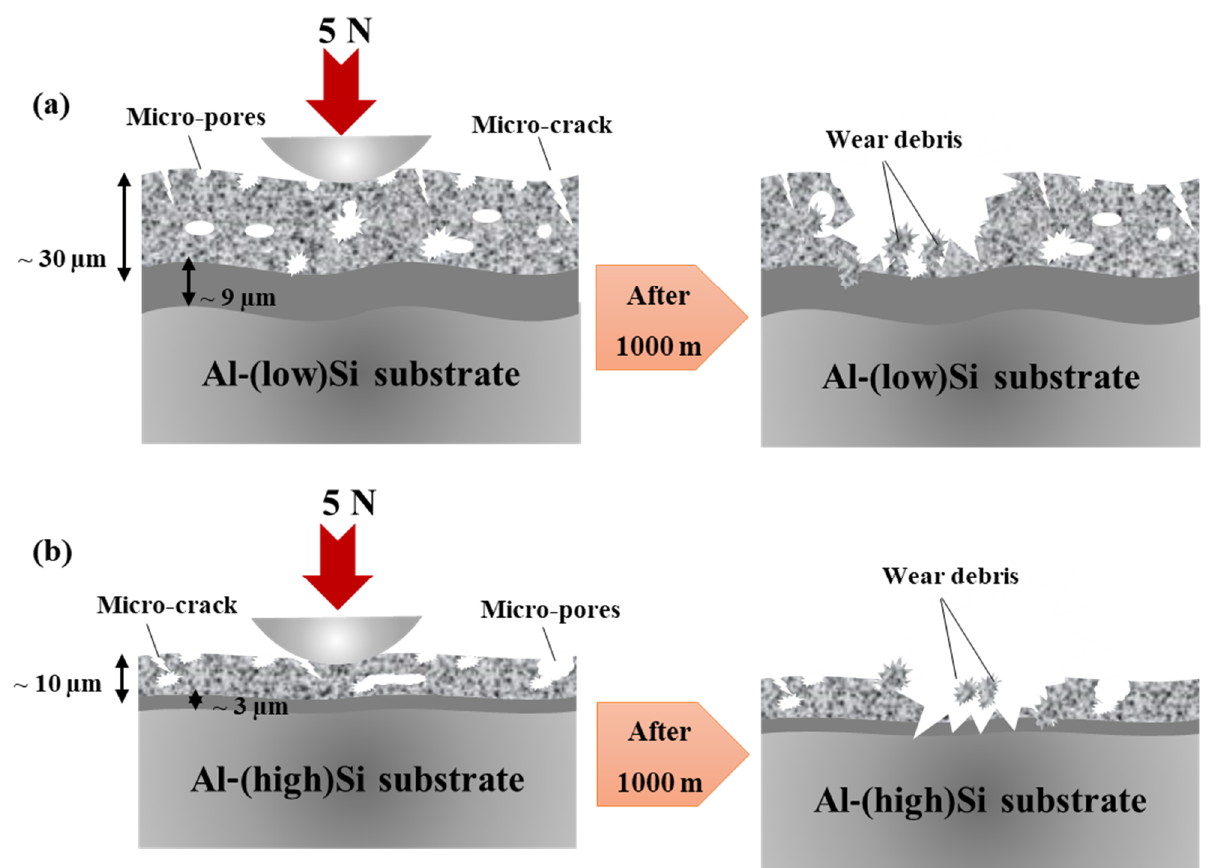
Figure 17. Schematic of the mechanism of wear phenomenon for substrate with ( a ) low silicon content, and ( b ) high silicon content. Table 2. Wear tracks’ specifications obtained by analysis of line profile specimens.